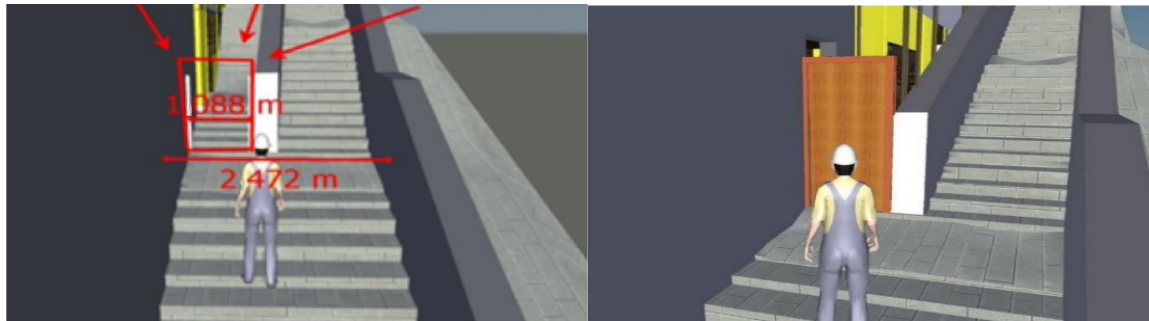
Figure 19. Limit access to the site with a door.